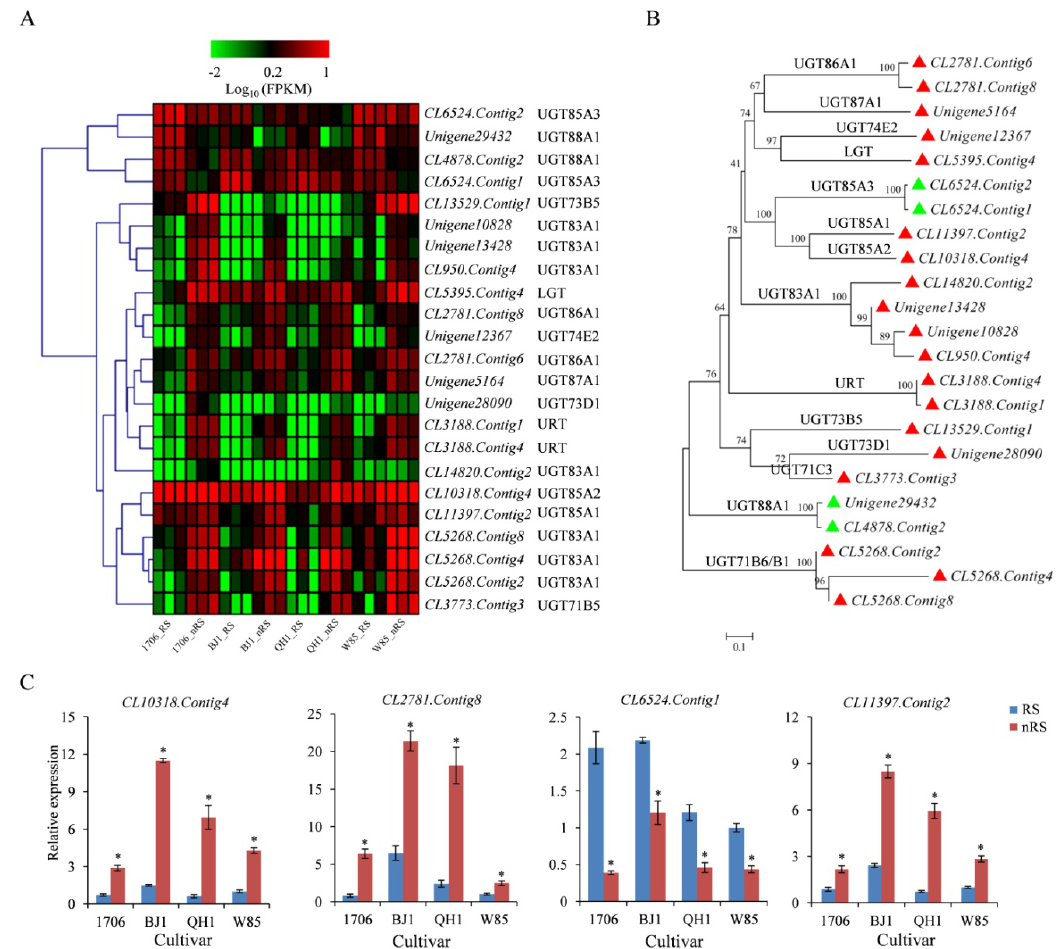
Figure 8. Expression patterns of UGTs between radial striations and non-radial striations of R. glutinosa. ( A ) Heat map representing expression dynamics of unigenes belongs to UGT encoding genes. ( B ) Phylogenetic tree of UGT proteins was generated by the neighbor-joining method using software of MEGA 6.0. ( C ) Relative expression levels of four UGT genes in radial striation and non-radial striation from 1706, BJ1, QH1, and W85 by qRT-PCR. Vertical bars indicate the standard deviation of three biological replicates. * indicate a significant difference at the p < 0.05 level.